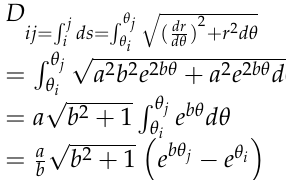
7 of 18 Algorithm 1: Pseudo-code of the EPC algorithm. Begin generate initial population array of EPs (Colony Size); generate position of each EP; generate cost of each EP; determine initial heat absorption coefficient; for it= 1 to MaxIteration do generate repeat copies of population array; for i= 1 to n population, do if cost j < cost i then calculate heat radiation (Equation (9)); calculate attractiveness (Equation (10)); calculate coordinated spiral movement; determine new posi-